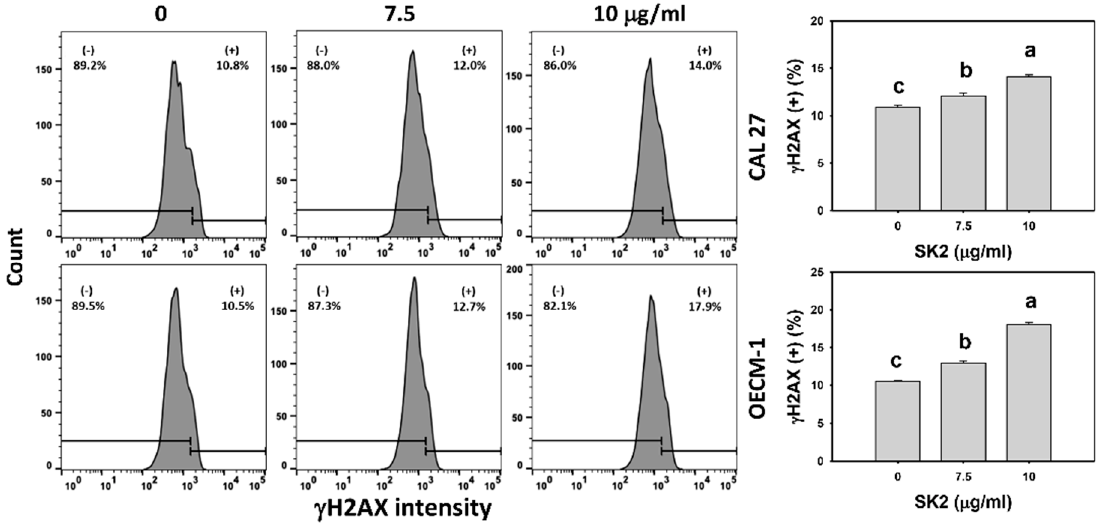
Figure 8. SK2 prompts γ H2AX induction in oral cancer cells. γ H2AX detections and statistics are provided. Cells were exposed to SK2 (0 (0.1% DMSO), 7.5, and 10 µ g/mL) for 24 h. (+) in each panel represents γ H2AX (+). Data (means ± SDs; n = 3) without overlapping characters differed significantly ( p < 0.05). For an example of CAL 27 and OECM-1 cells, for different concentrations, different characters indicate significant